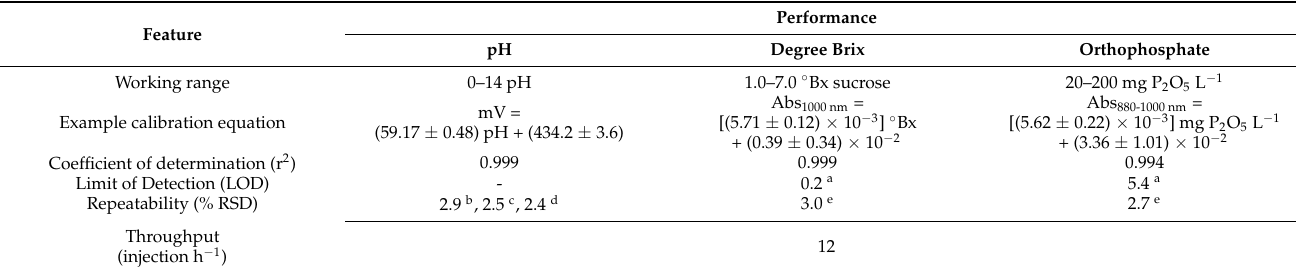
Table 3. Analytical features of the SIA system (Figure 1a) for measurements of pH, degree Brix and orthophosphate in raw sugarcane juice.